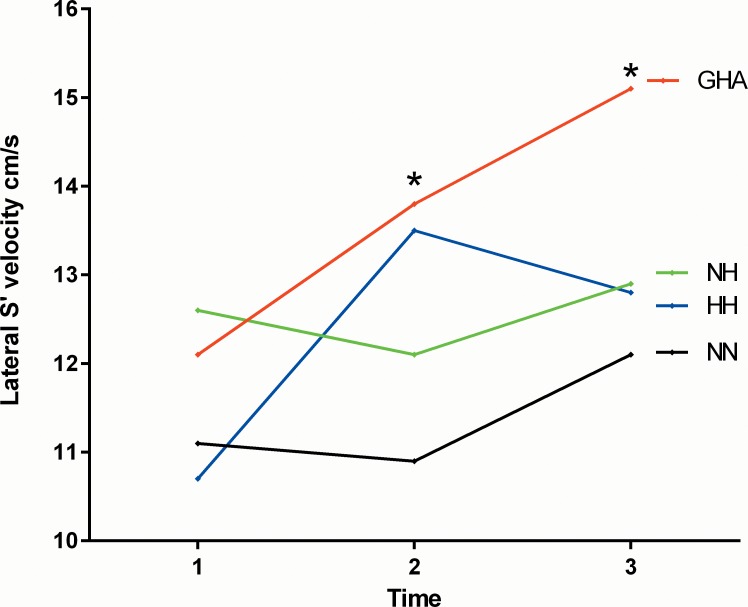
Changes in the left ventricular lateral S’ velocities (marginal means) with differing experimental conditions and duration of hypoxia (time 1 = baseline rest, time 2 = 15 minutes post exercise and time 3 = 120 minutes post exercise).* demonstrates between group differences on post test.